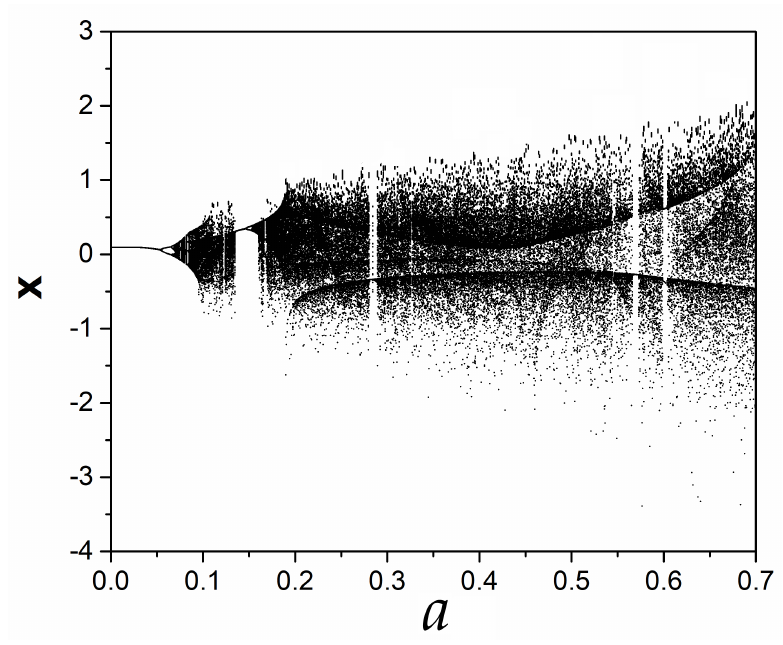
Figure 5. Bifurcation diagram of x versus a for b = 0.1.